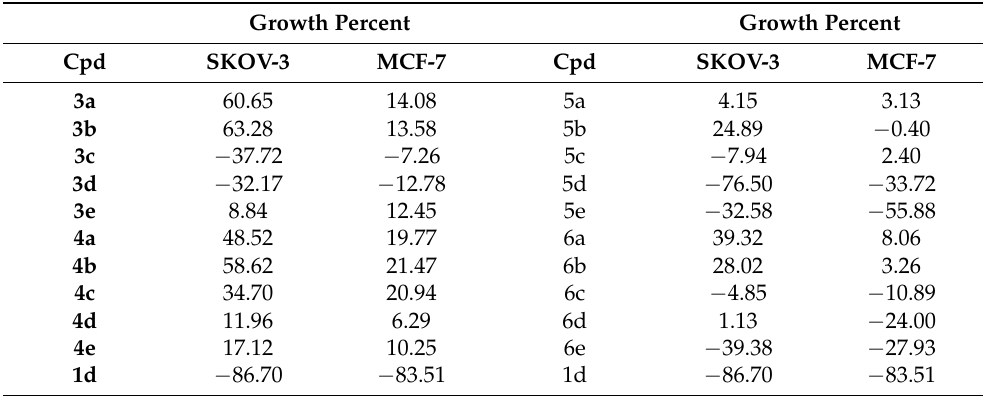
Table 2. Growth percent values of SKOV-3 and MCF-7 cells in the presence of derivatives 3 – 6 at the concentration of 10 µ